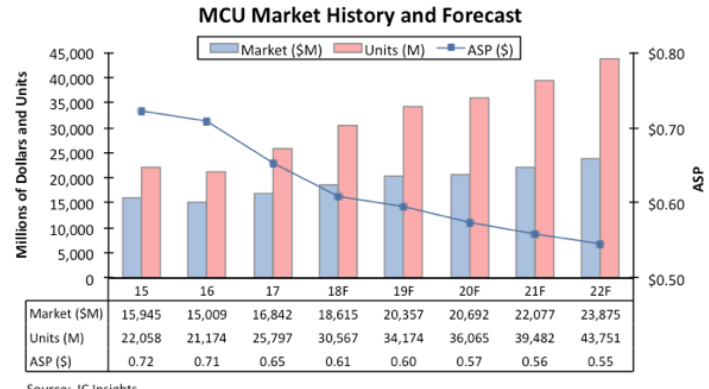
Figure 2. The history of the MCU market